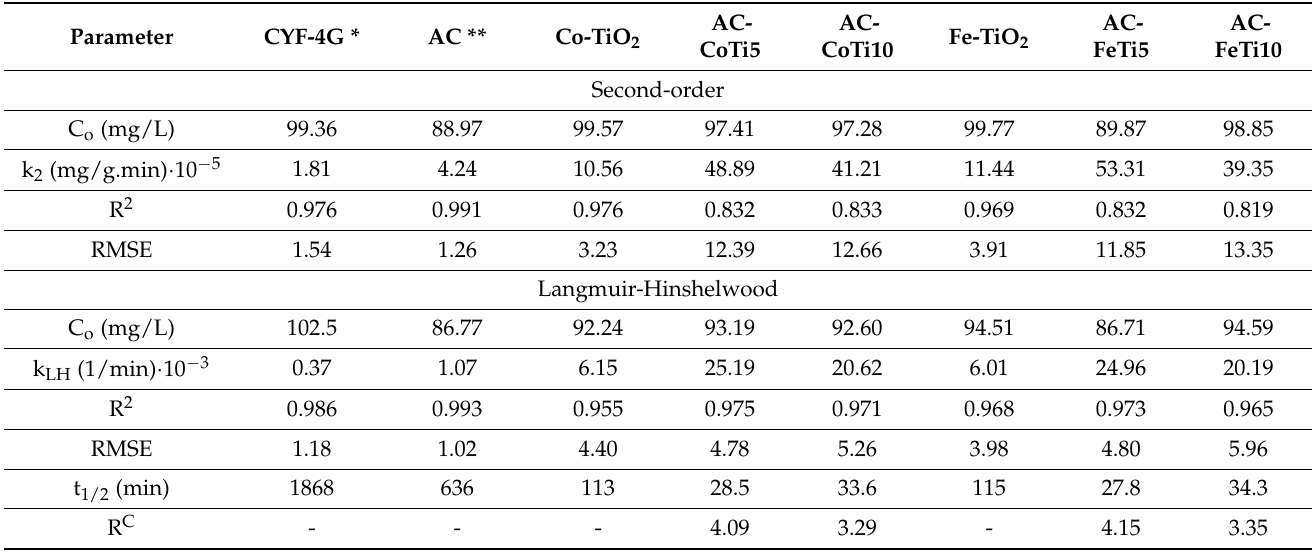
Table 2. Kinetic parameters on the rate of degradation of CYF-4G without and with AC, Fe-TiO 2 , Co-TiO 2 , Fe-TiO 2 /AC, and Co-TiO 2 /AC composites.